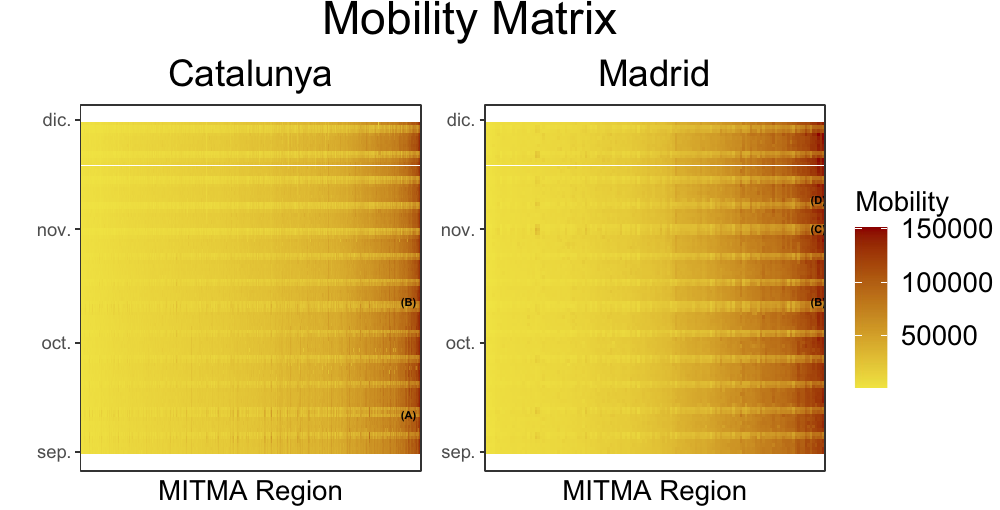
Figure 4. Number of incoming trips in Cataluña and Madrid: consider annotation ( A ) which is displayed in the Cataluña figure but not in the Madrid figure. There was a reduction in mobility at this point (indicated by a lighter shade of yellow) because there was a public holiday in Cataluña, there was no public holiday in Madrid on this date. Moreover, annotation ( B ) shows a reduction in mobility for both Cataluña and Madrid. On this date there was a national holiday and thus both regions mobility were reduced. On the y-axis, dic refers to Diciembre (December).